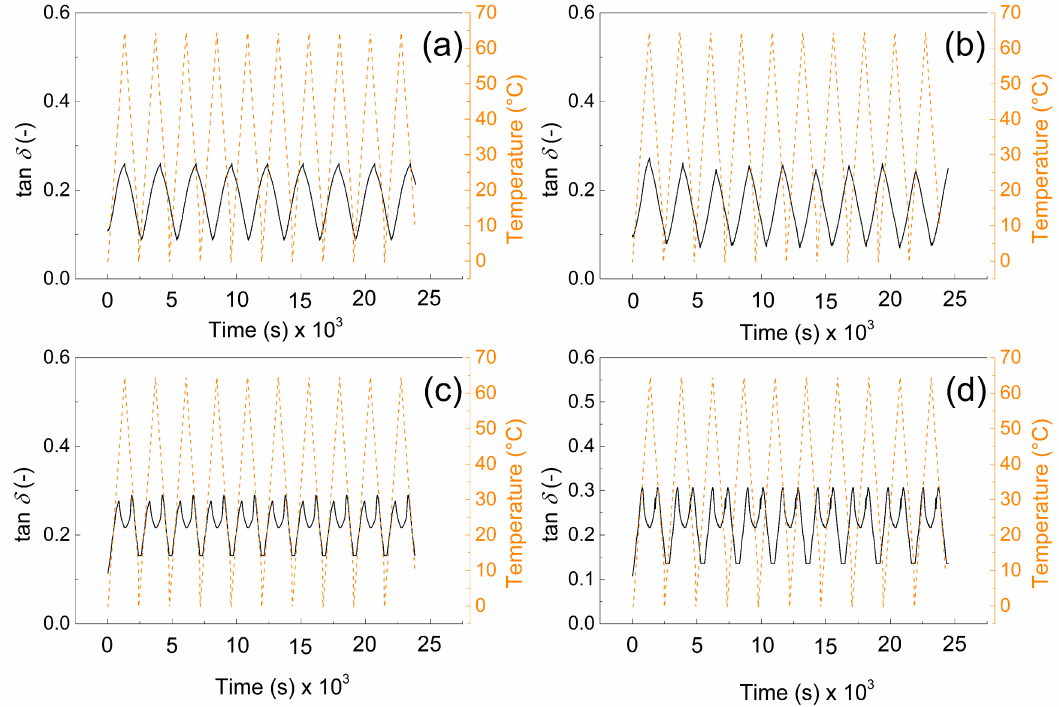
Figure 7. DMA investigation of the ( a ) P1, ( b ) P05, ( c ) PW1, and ( d ) PW05. To show, how the fabricated materials can be applied in the real-life applications, the heat flux investigations and calculated energies passing through the samples were calculated. Schematic illustration and table with calculated energies is depicted in Figure